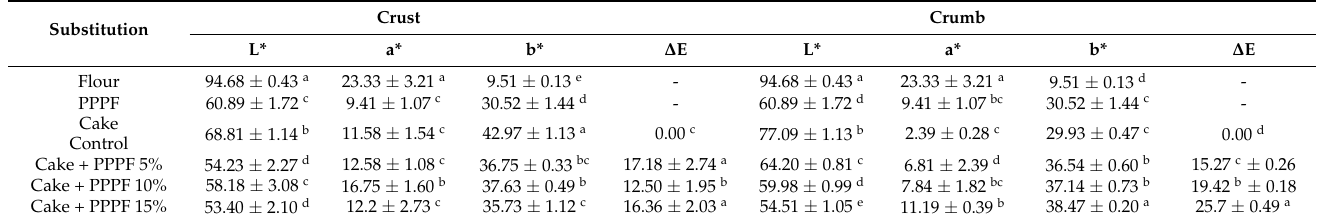
Table 8. Color values of cakes prepared by replacing flour with various levels of